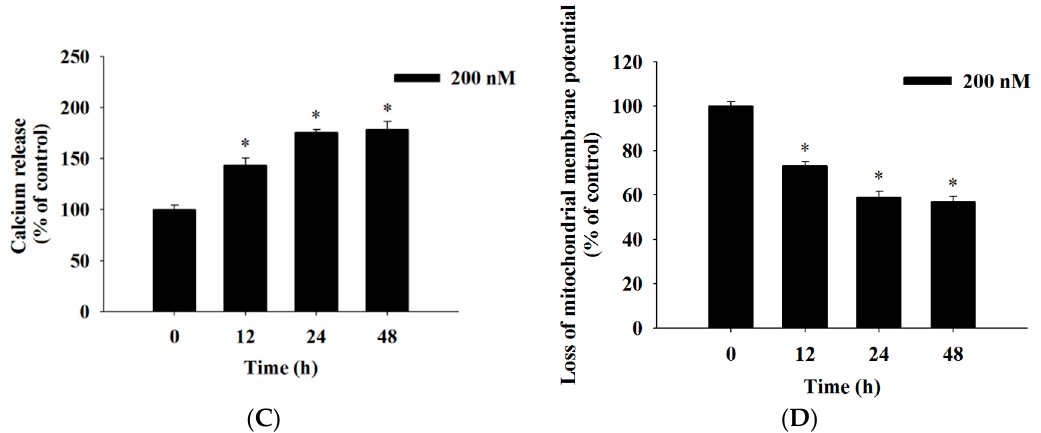
Figure 4. Bufalin induced reactive oxygen species and Ca 2+ production and decreased the levels of mitochondrial membrane potential ( ΔΨ m ) in U-2 OS cells. Cells (1 × 10 5 cells/well) were treated with bufalin (200 nM) for various time periods. Cells were isolated and were re-suspended in 500 μ L of DCFH-DA (2 ′ ,7 ′ -Dichlorofluorescin diacetate) (10 μ M) for further ROS (Reactive oxygen species) (H 2 O 2 ) ( A : short time, B : long time), ( C ), re-suspended in 500 μ L of Fluo-3/AM (2.5 μ g/mL) for further intracellular Ca 2+ concentrations, and ( D ) re-suspended in 500 μ L of DiOC 6 (4 μ mol/L) for 30 min for further levels of ΔΨ m measurement, as described in Materials and Methods. The results are shown as a mean ± SD ( n = 3); * p < 0.05, significant difference between bufalin-treated groups and the control as analyzed by Student’s t test.